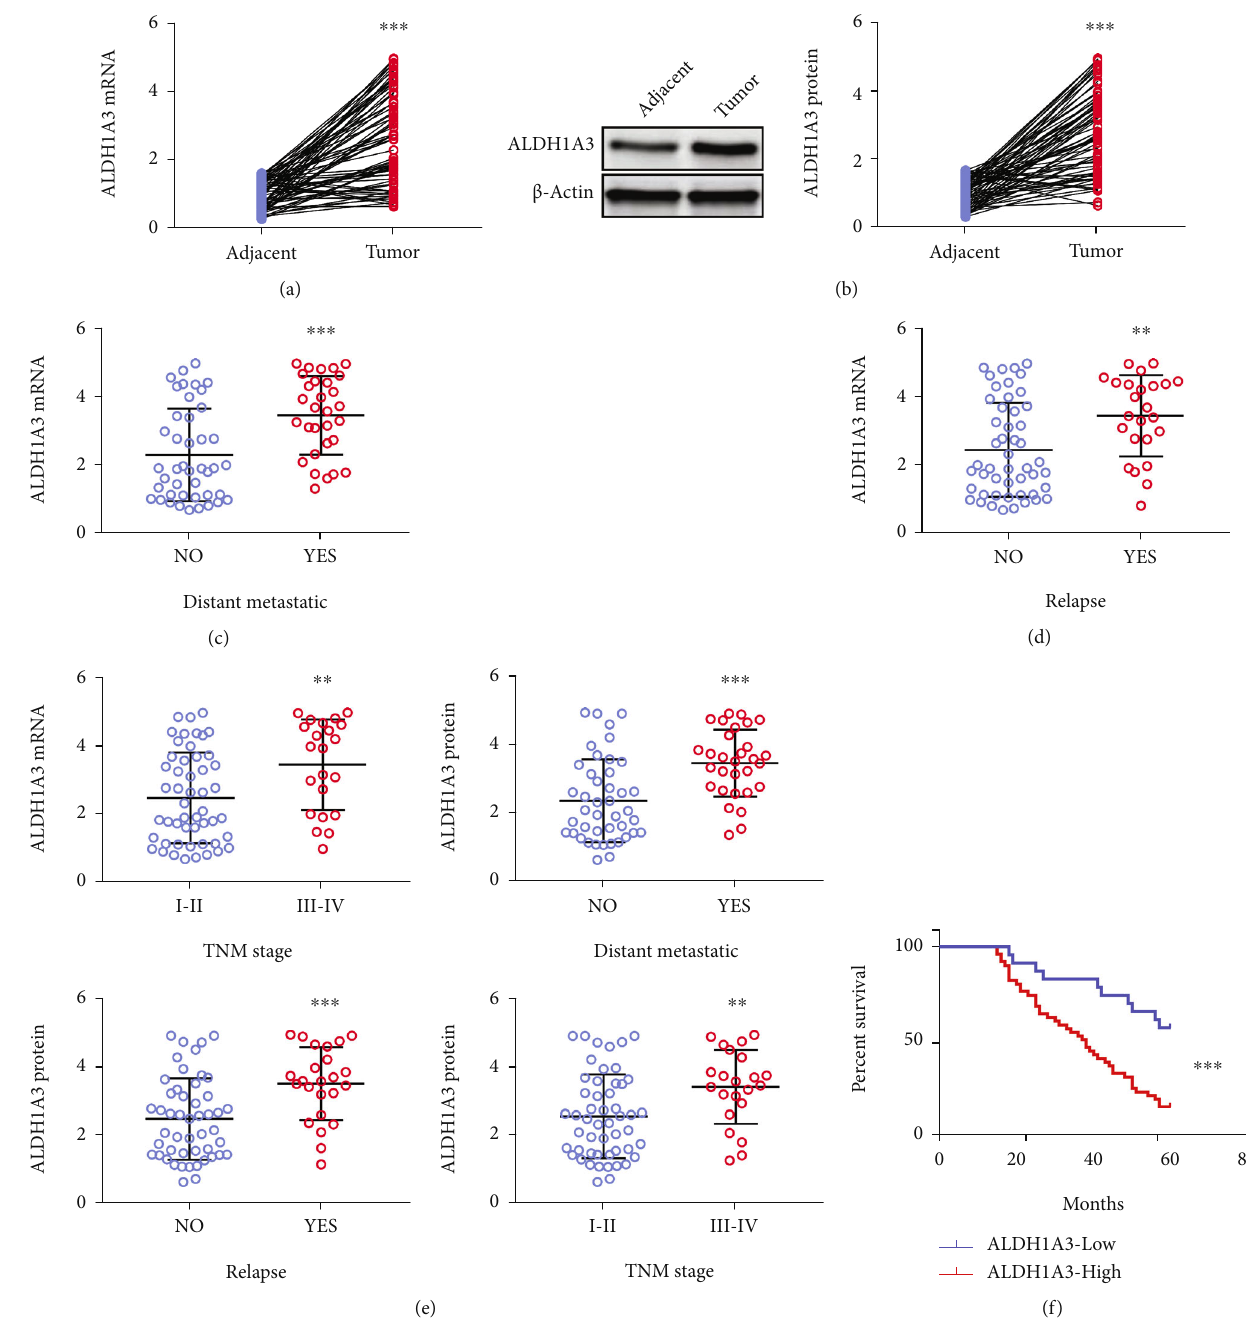
Figure 1: Expression of ALDH1A3 was associated with the clinicopathological characteristics and poor prognosis in patients with colorectal cancer. mRNA (a) and protein level (b) of ALDH1A3 expression in 73 human CRC samples and paired adjacent normal tissues ( n = 73 ). The expression level of ALDH1A3 was signi fi cantly higher in tumor tissues of (c) patients with metastatic CRC ( n = 43 ) than those without metastasis ( n = 30 ) or (d) patients with relapse CRC ( n = 49 ) compared with those without relapse CRC ( n = 24 ) or (e) patients with stage III – IV CRC ( n = 51 ) than those with stage I – II CRC ( n = 22 ). (f) Kaplan – Meier curve of overall